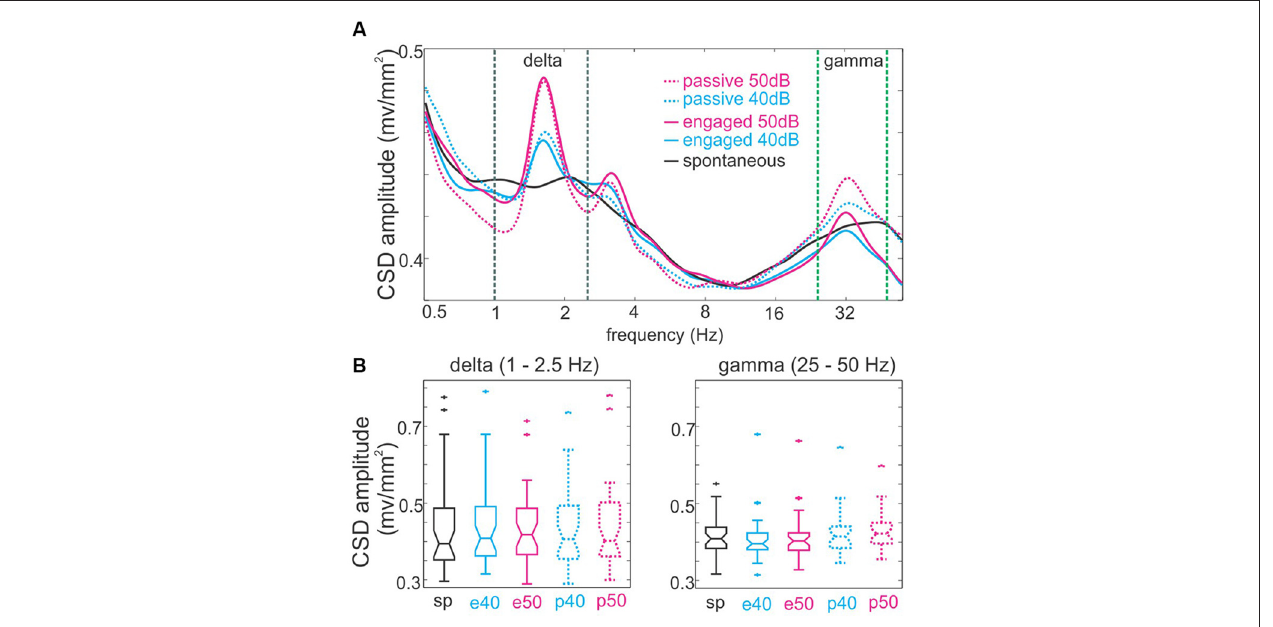
FIGURE 4 | The amplitude of spontaneous and auditory stimulus stream related delta and gamma band neuronal activity. (A) The spectra averaged across all experiments ( n = 48) show that the presentation of click-train streams results in discrete peaks that correspond to the repetition of clicks within click-trains (33 Hz) and the rate at which click-trains occurred in the stream (1.6 Hz). These peaks are larger in the case of louder streams. The dotted lines mark the delta (black, 1–2.5 Hz) and gamma (green, 25–50 Hz) frequency bands. (B) Boxplots show pooled amplitudes of neuronal activity averaged in the delta (left) and gamma (right) frequency